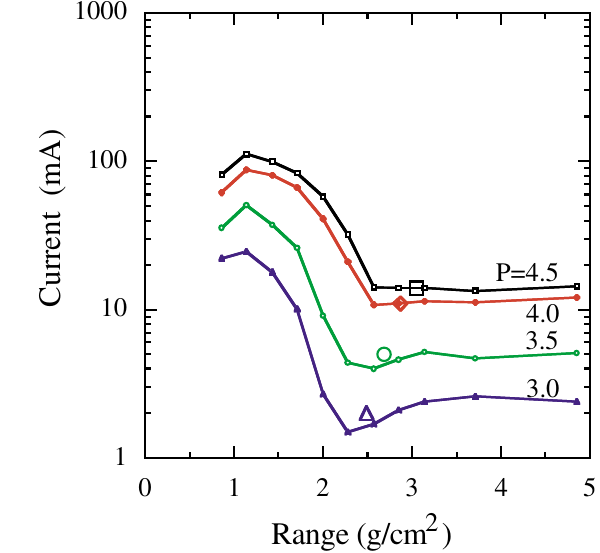
FIG. 8. (Color) Momentum spectrum from the spectrometer (cid:5) 14 : 1 MV = m . for E acc